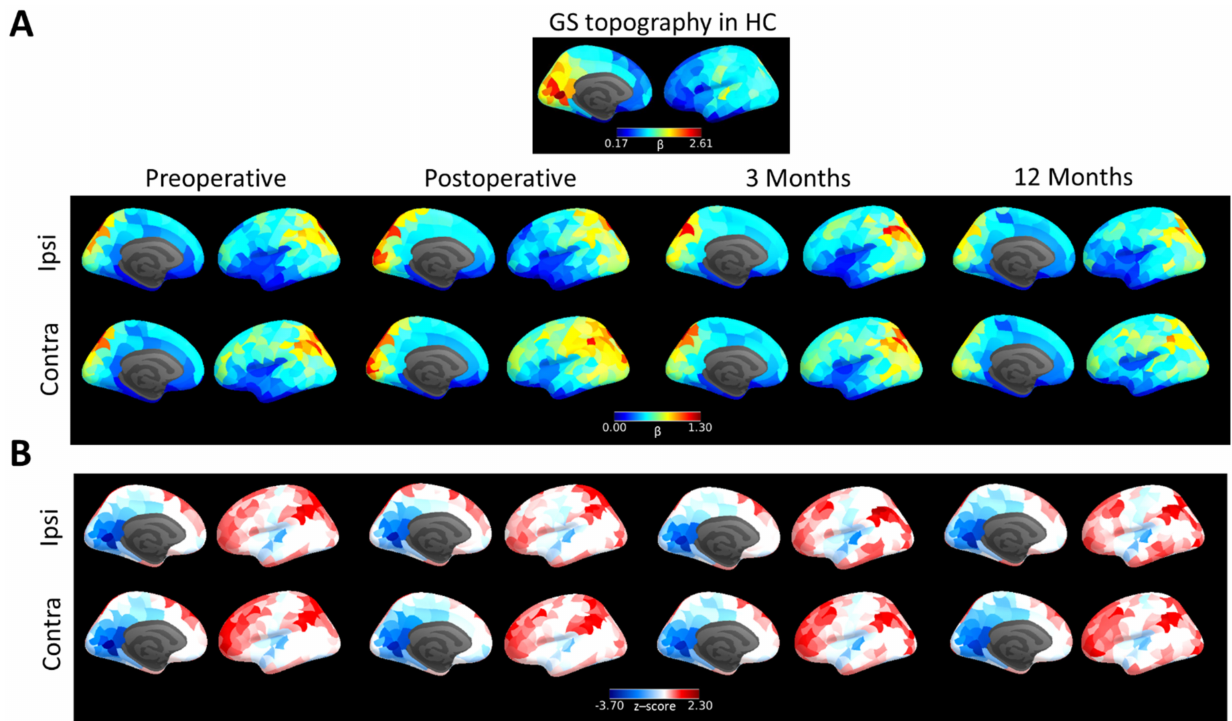
Figure 3. GS topography of brain tumour patients. ( A ). GS topography of HCs compared with brain tumour patients scanned before surgery (leftmost column), within a week after surgery (second column) and 3 months (third column) and 12 months follow-up (rightmost column) for the hemisphere containing the tumour (ipsi) and the contralateral healthy hemisphere (contra). ( B ). GS topography of brain tumour patients normalised to HC values (z-scores; blue represents reduced regional coupling with GS in patients compared with